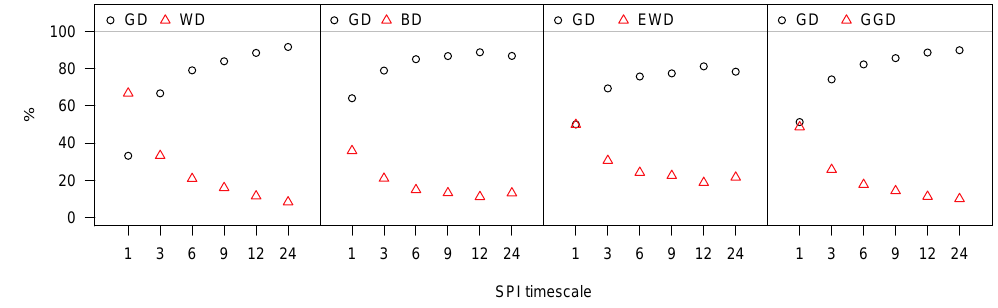
Fig. 12. AICD frequencies (CRU data set): percentages of all grid points and months a distribution yields AICD equal zero for the European region. The GD (black dots) is compared to the WD, BD, EWD and GGD (red triangles) in dependence of the SPI time scale.